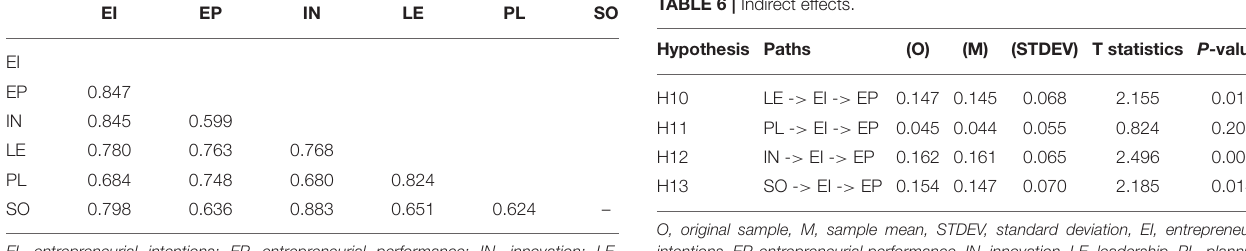
TABLE 6 | Indirect effects.